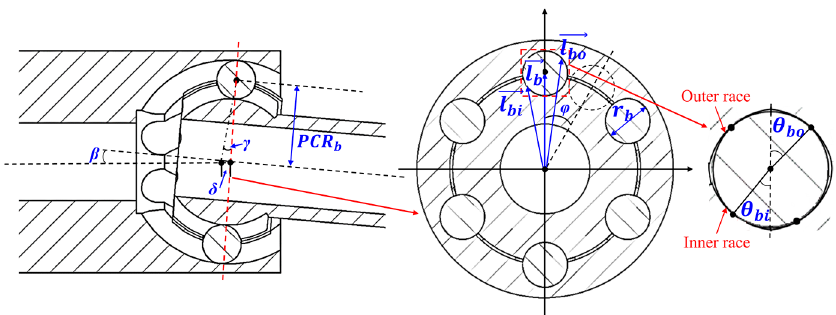
Figure 4. Geometric relationship of components in the ball cage universal joint.